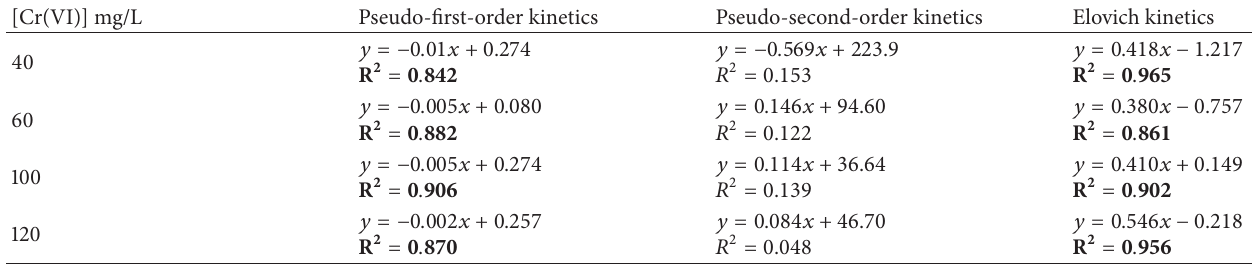
Table 1: Regression equations and correlation factors using pseudo-first-order, pseudo-second-order, and Elovich kinetic models for the biosorption of Cr(VI) by waste potato peel.